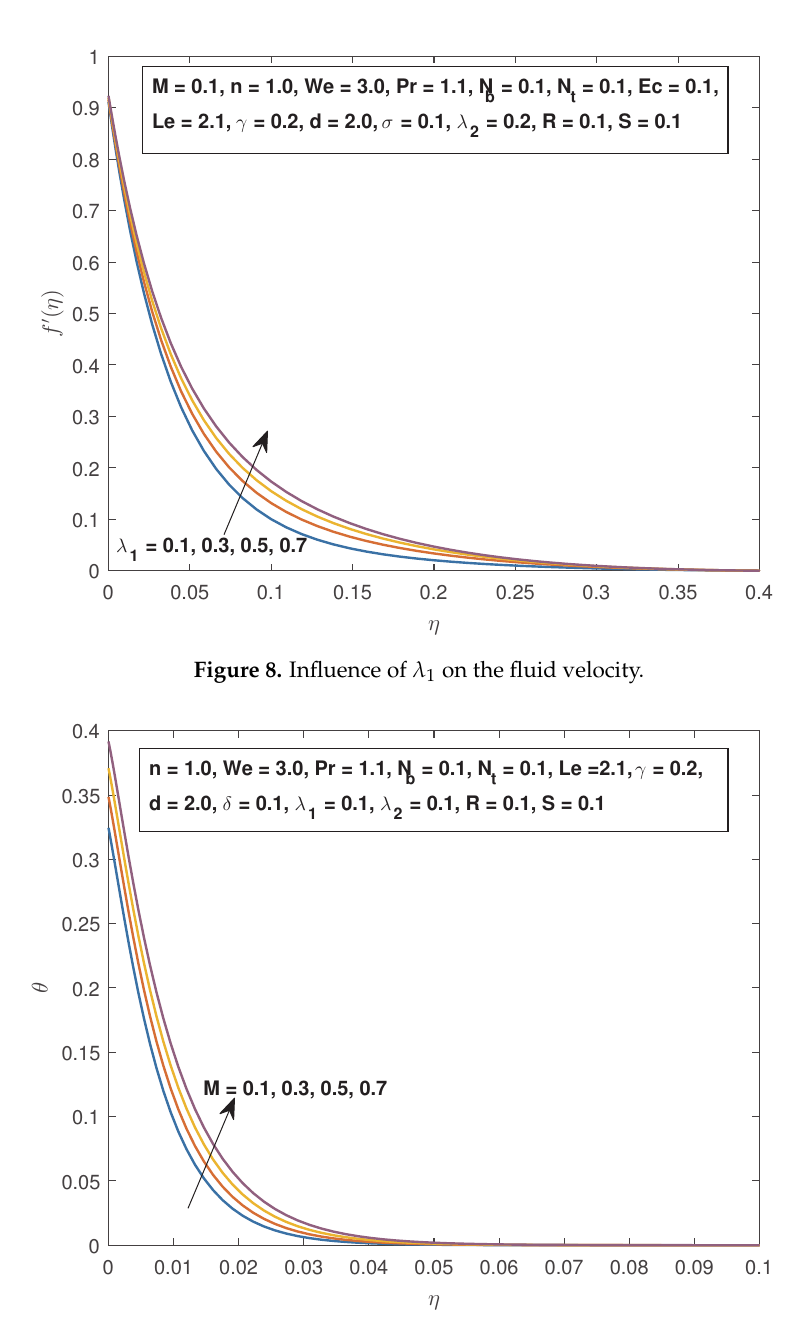
Figure 9. Influence of M on the fluid